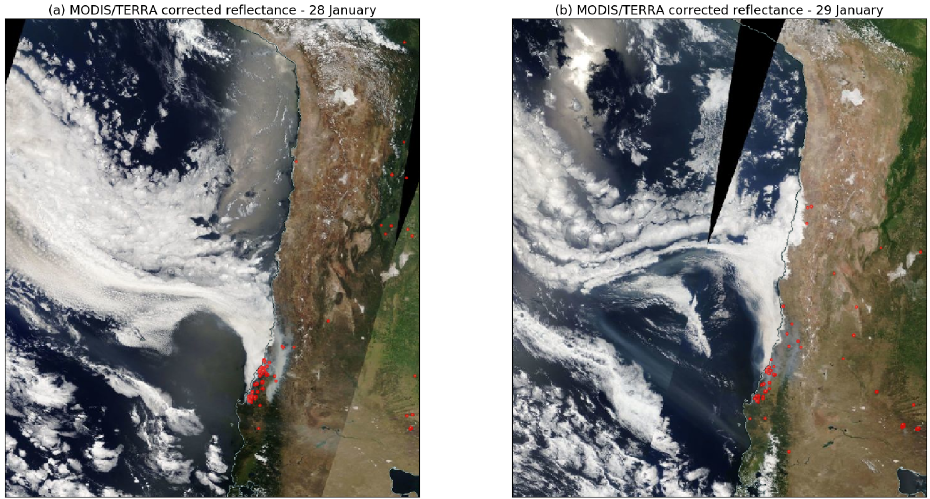
Figure A2. ( a ) SSA at 20:00 UTC recorded by AERONET (440, 675, 870 and 1020 nm) in January 2017. ( b ) Volume size distribution of aerosols before and during the fire events. Whiskers show one standard deviation. Observations from Santiago Beauchef AERONET station.